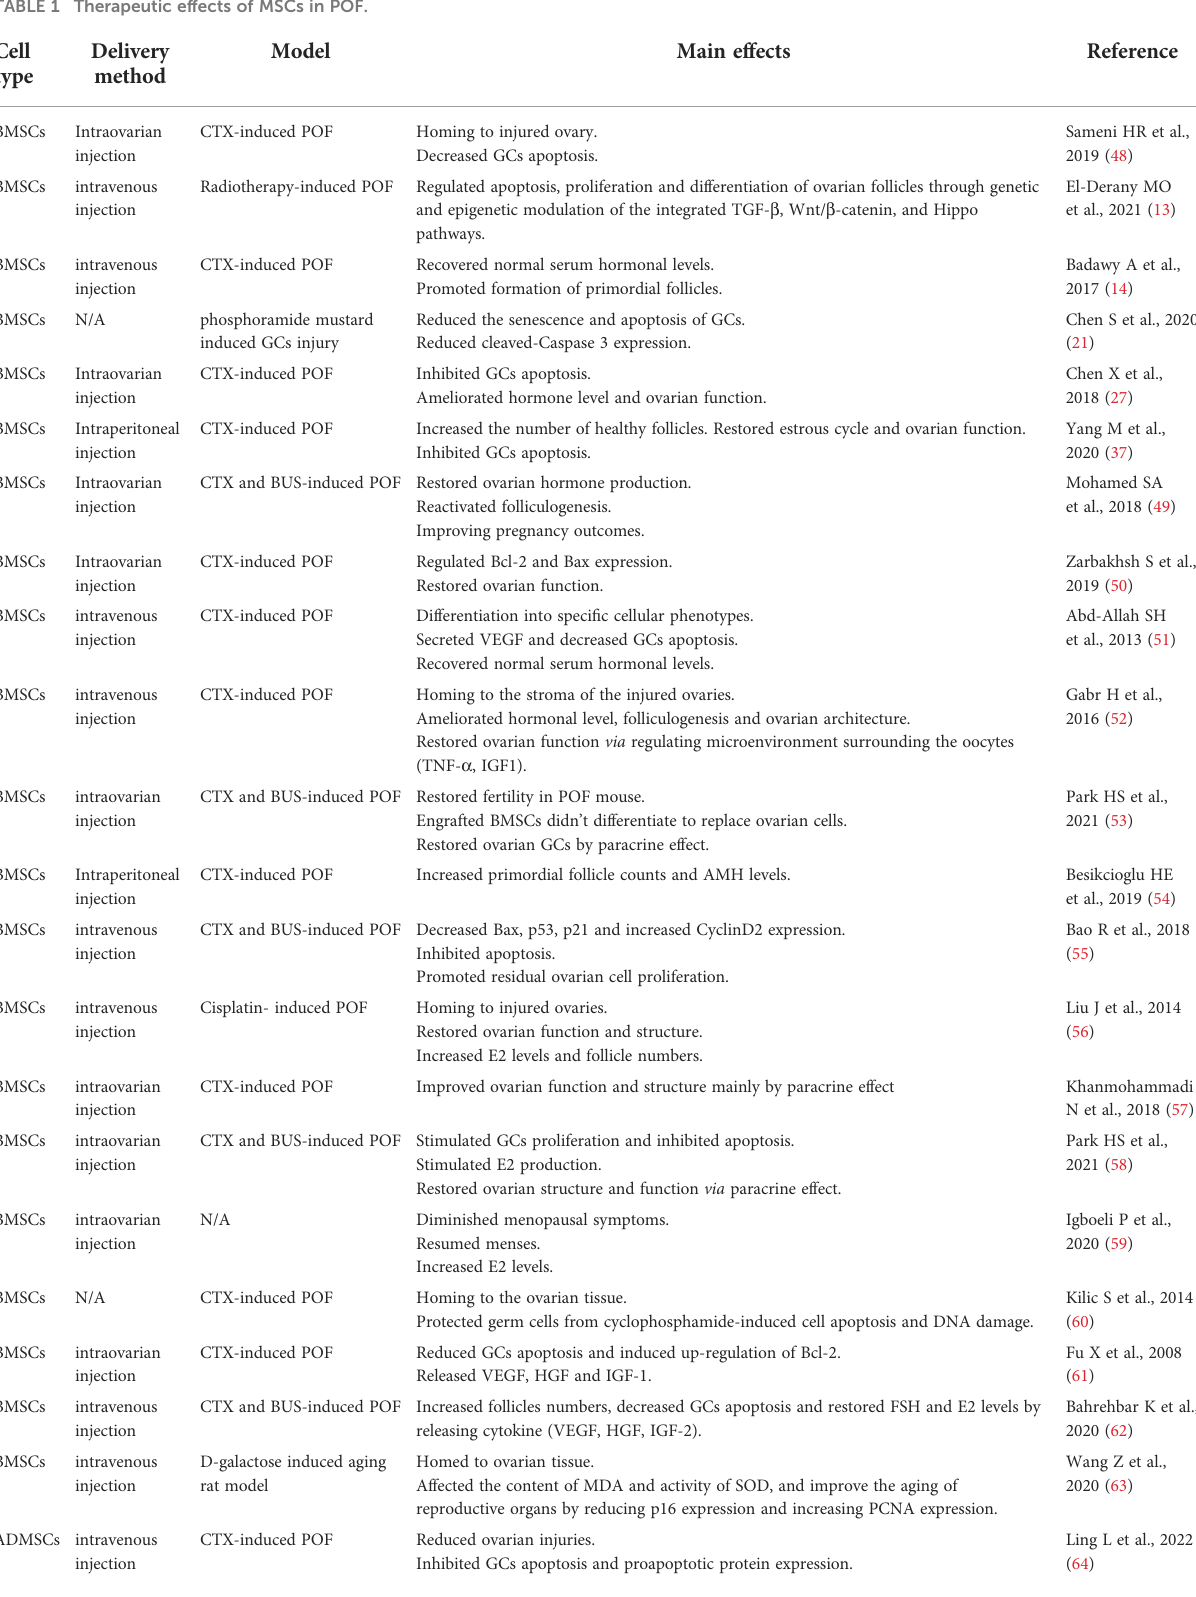
TABLE 1 Therapeutic effects of MSCs in